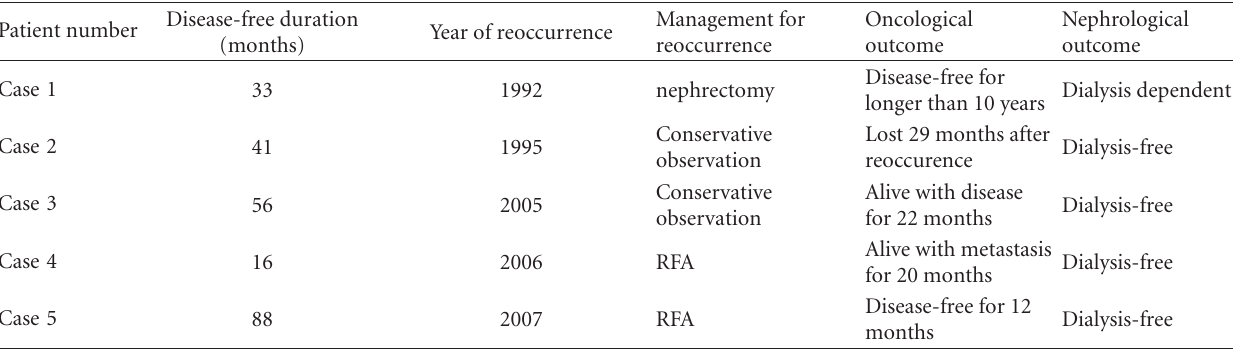
Table 2: Clinical course and outcome of the